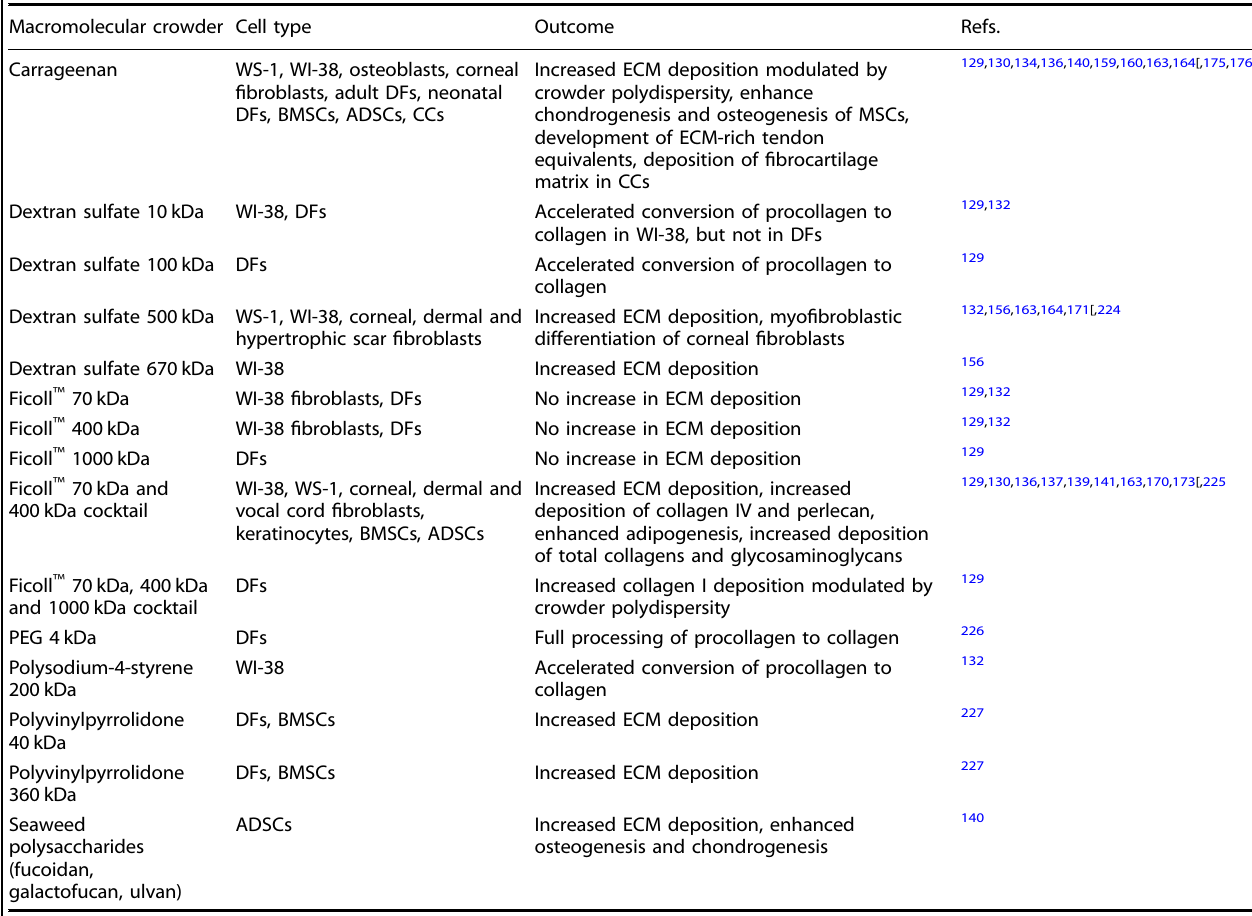
Table 9. Macromolecular crowders used in vitro for human cell culture. Macromolecular crowder Cell type Outcome